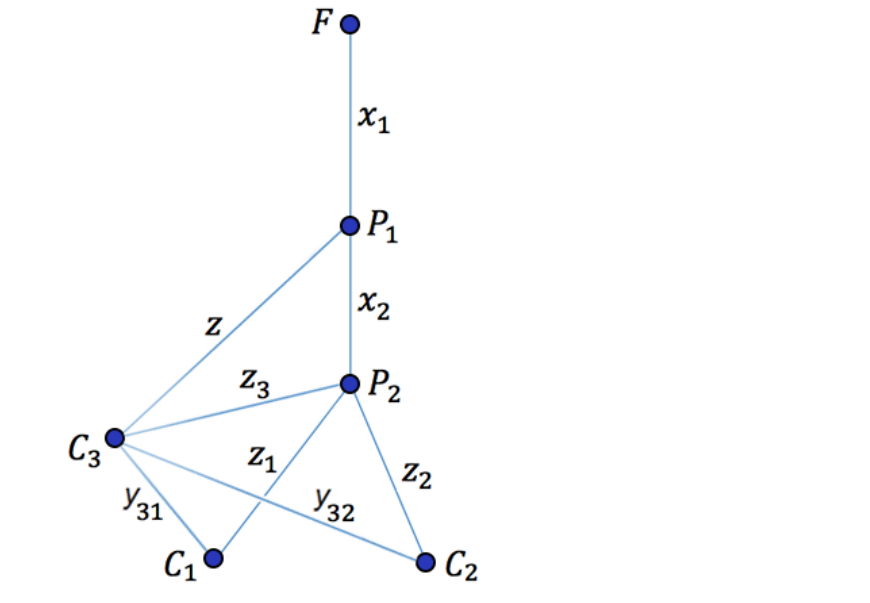
Figure 4. Present situation. By construction, the shortest paths from the customers to the factory are given by: 𝐶 1 𝑃 2 𝑃 1 𝐹, 𝐶 2 𝑃 2 𝑃 1 𝐹 and 𝐶 3 𝑃 1 𝐹.